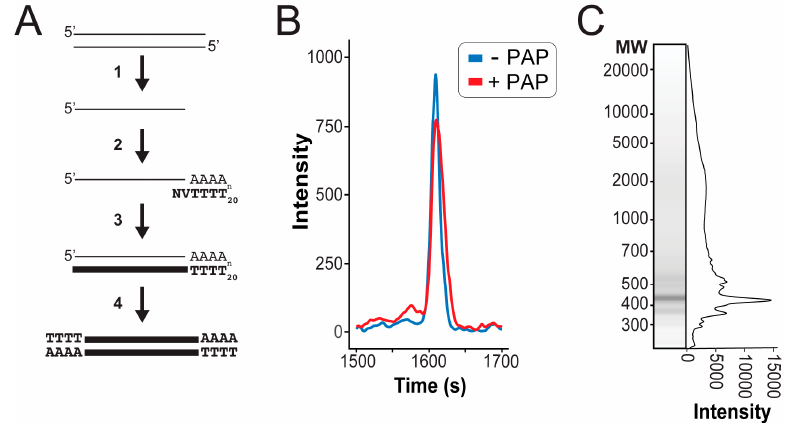
Figure 2. Overview of cDNAs synthesis from dsRNAs using poly(A) polymerase for next-generation sequencing. ( A ) (1) Purified dsRNAs are denatured and rapidly cooled to separate RNA strands. ( 2 )